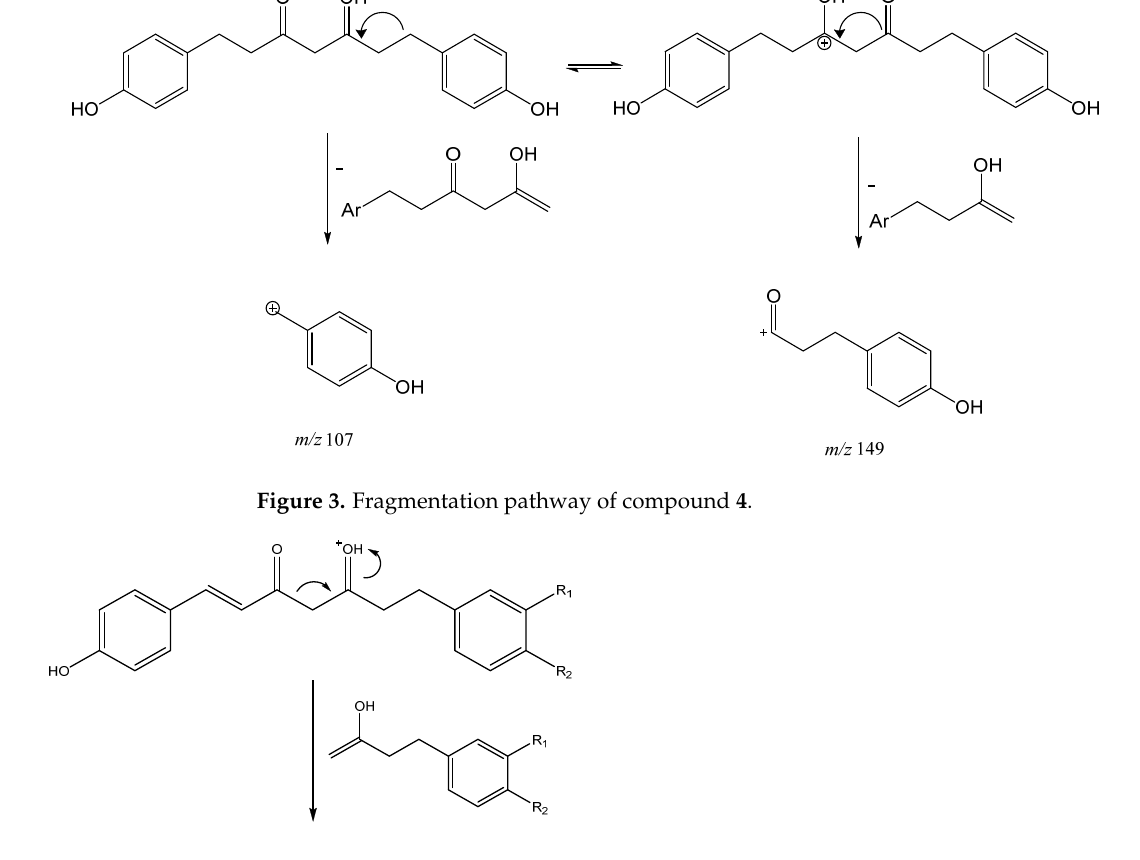
OMe Figure 2. Structure and main fragments for compounds 22 , 25 and 28 . A characteristic product ion is constituted by the neutral loss of carbon monoxide (28 uma) from the fragment at m/z 147, which gives rise to the fragment observed at m/z 119. On the other hand, the fragment at m/z 177 suffers a neutral loss of CH 3 OH (32 uma) to produce the fragment at m/z 145, which is observed for hydroxyl and methoxy groups in ortho position in the benzene ring, as found in curcumin and demethoxycurcumin [26,27]. Peak 4 (Rt = 11.60 min) with [M + H] + at m/z 313.1422 (C